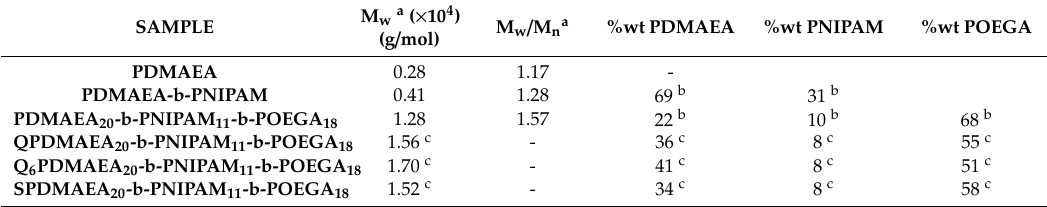
Table 1. Molecular characteristics of all synthesized triblock